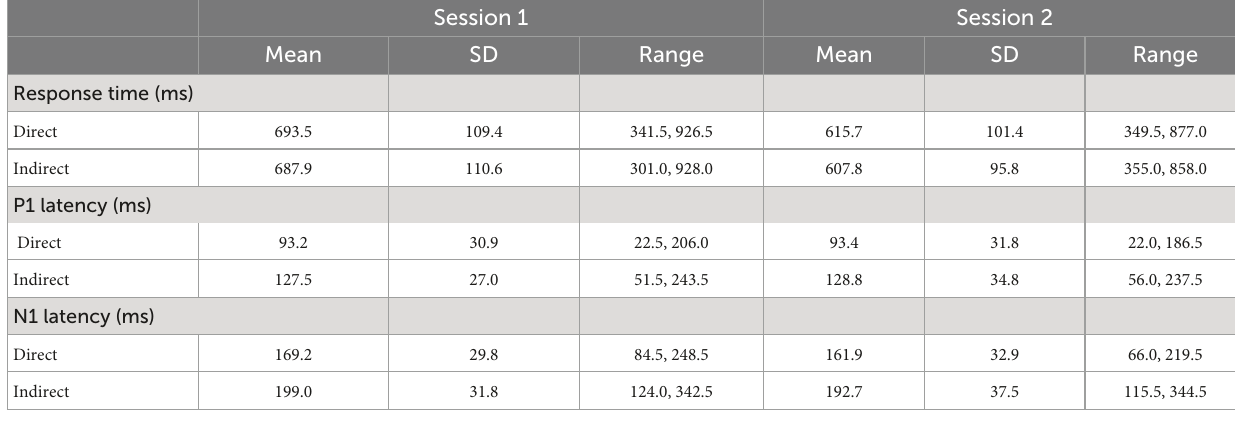
TABLE 4 Dependent variables by group and